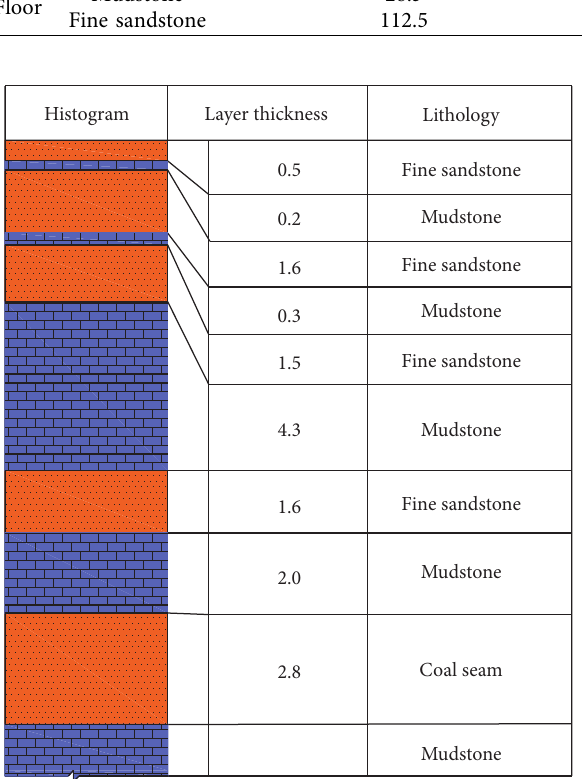
Figure 1: Comprehensive histogram.